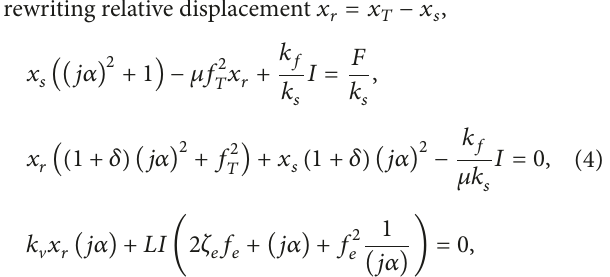
rewriting relative displacement 𝑥 𝑟 = 𝑥 𝑇 − 𝑥 𝑠